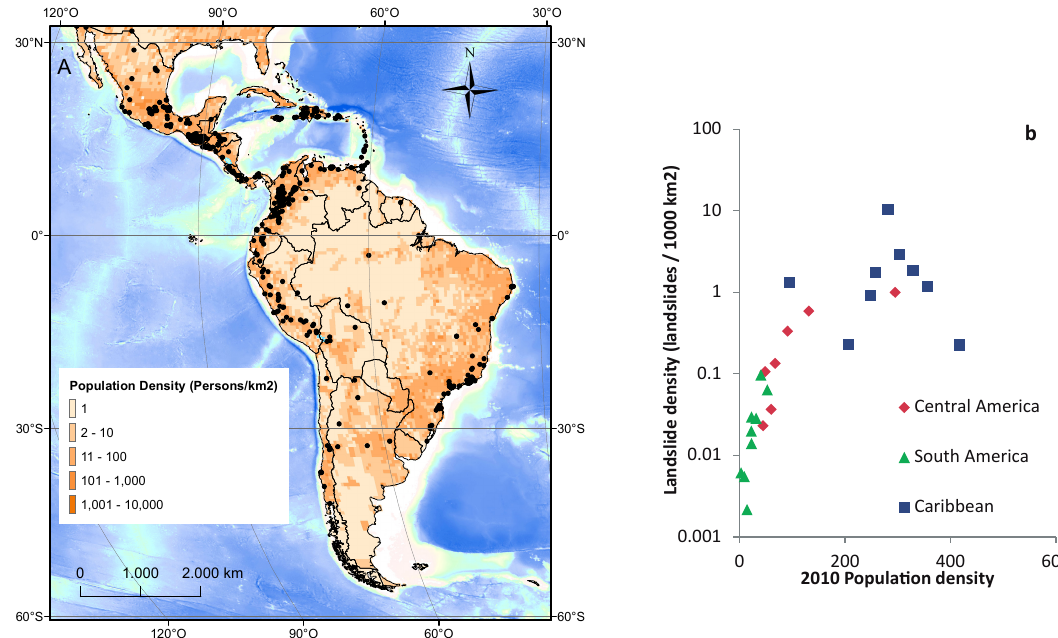
Figure 9. (a) Population density map (year 2000 data, NEO, 2014) and fatal landslide distribution (black dots). (b) Landslide density versus population density per